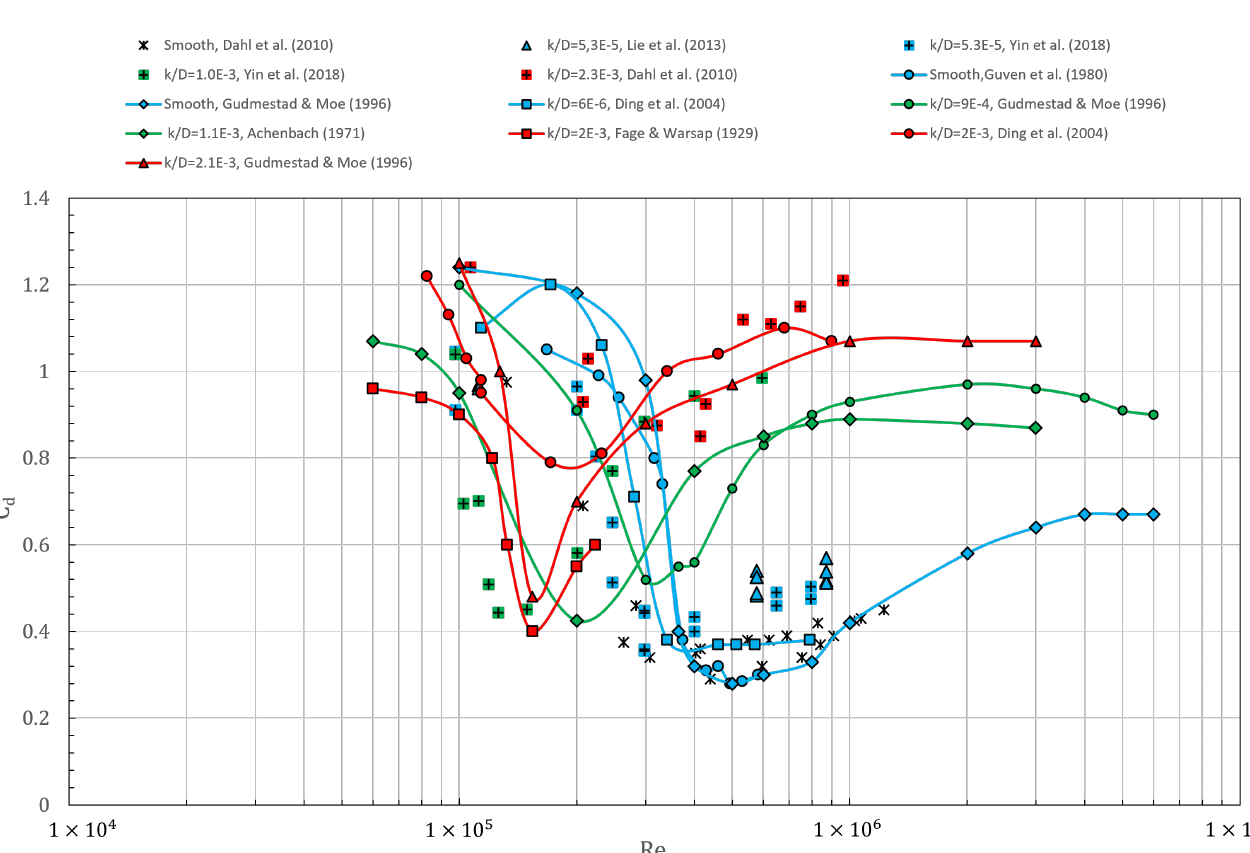
Figure 7. Collection of mean drag coefficients on a circular cylinder as a function of Reynolds number and surface roughness ratio